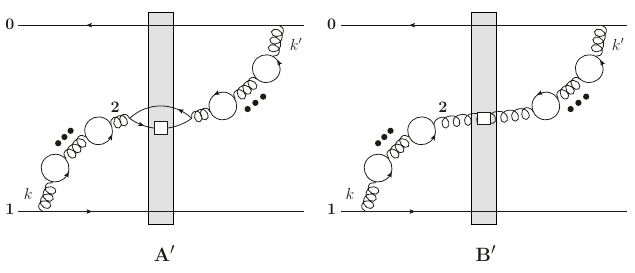
Figure 10 . Quark-loop corrections for the polarized gluon emission diagram from eq. (5.13b). Again, the ellipsis indicate a sum over all possible numbers of quark loop corrections, summed from zero to